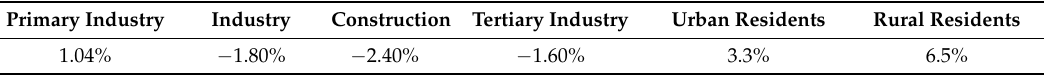
Table 7. Annual rate of change in the intensity of electricity consumption under efficiency